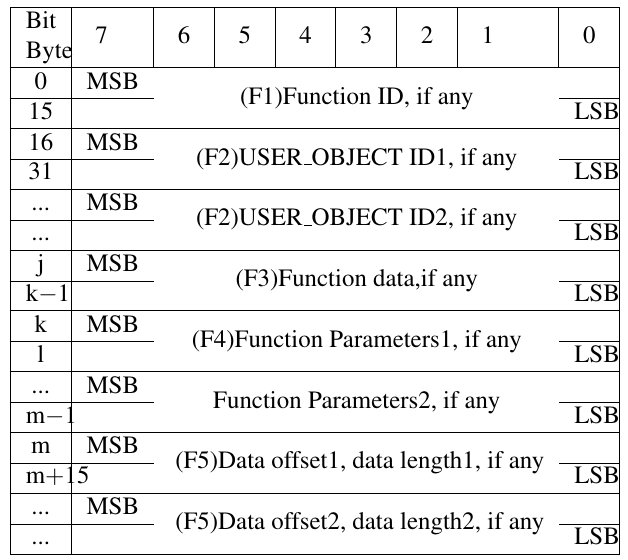
Table 3. Data-Out Buffer format